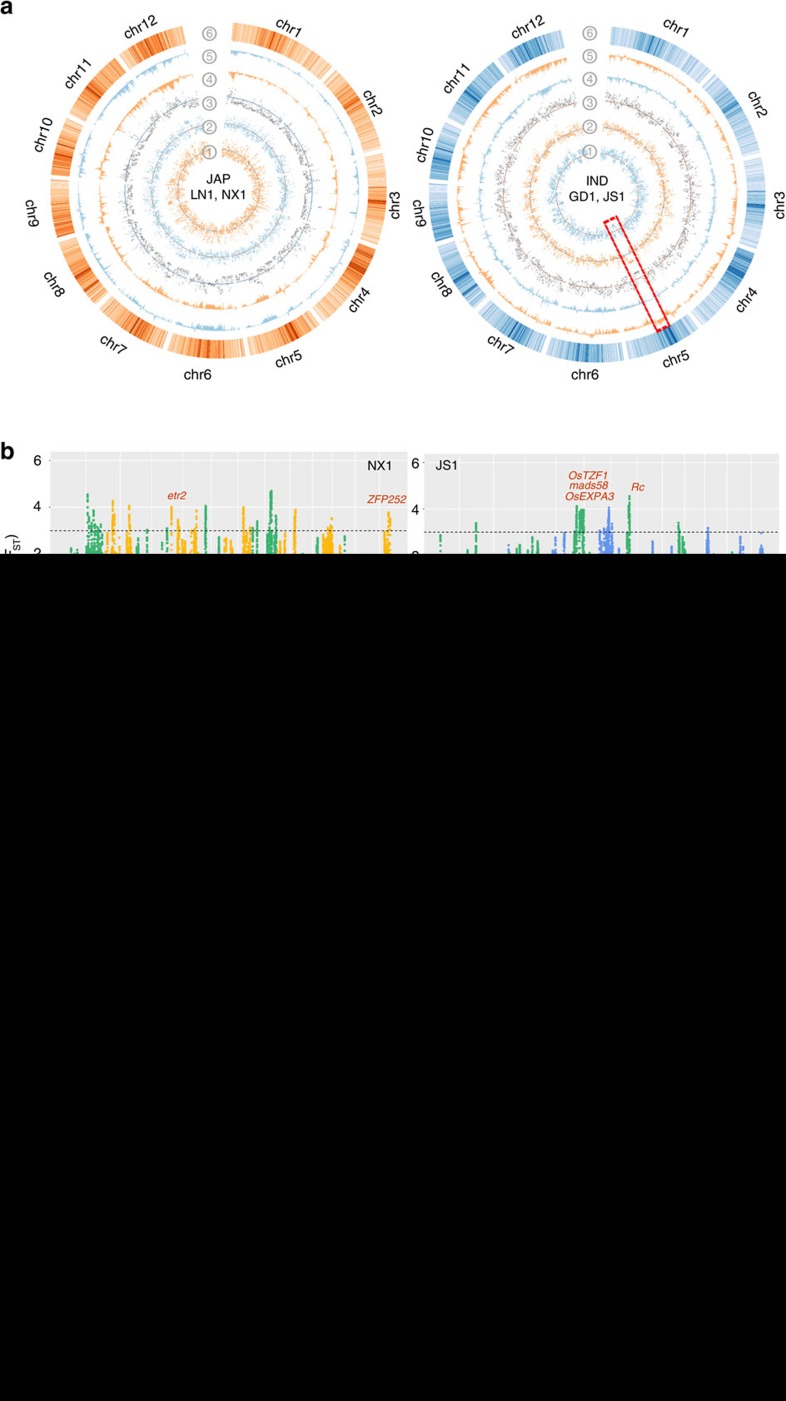
Genomic differentiation and selection between weedy and local cultivated rice.(a) Genomic distribution of population summary statistics of japonica (left) and indica type (right) weedy and local cultivated rice. The population parameters (π, Tajima's D) in this study were estimated in a 100 Kb window size along the reference genome. Legends for circles from inside to outside: Tajima's D of the LN1 (left) and GD1 (right) Tajima's D of NX1 (left) and JS1 (right); Tajima's D of TEJ (left) and IND (right); πJAP−πLN1 (left) and πIND−πGD1 (right), with inward present positive value; πJAP−πNX1 and πIND−πJS1 with inward present positive value; repeat density across the reference genome. (b) FST between weedy and cultivated rice from different locations. Japonica weedy rice from Ningxia (NX1) and Liaoning (LN1) and indica weedy rice from Jiangsu (JS1) and Guangdong (GD1) were illustrated, respectively. Some functionally known genes locating the significant divergent regions were shown. (c) A common genomic region with significant divergence in both indica and japonica weedy rice populations relative to their cultivated rice. The domestication gene Rc controlling pericarp colour and dormancy and a cluster of seed allergenic genes (RAL) locate in the region.